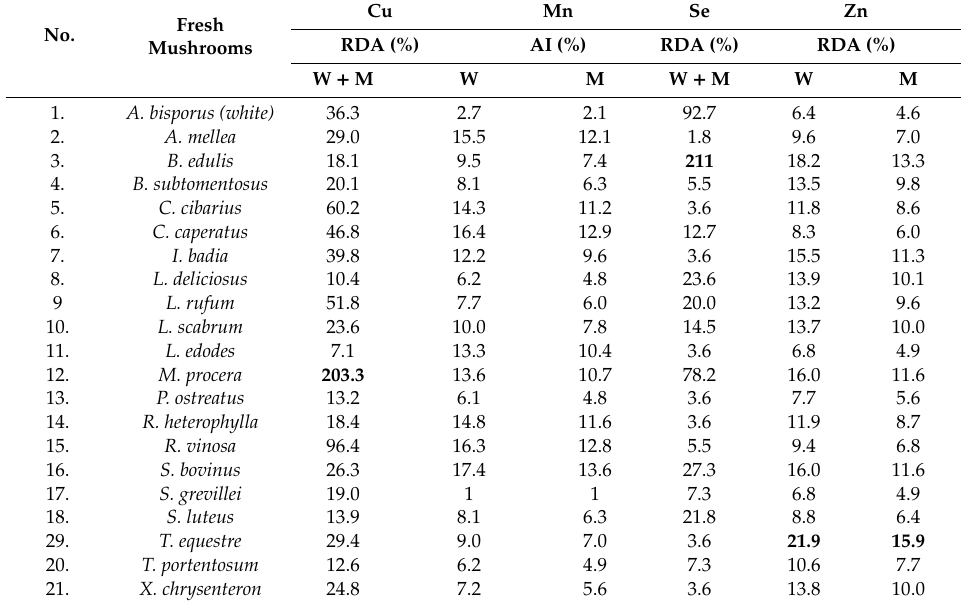
Table 6. Percentage implementation of nutrition standards for Cu, Mn, Se, and